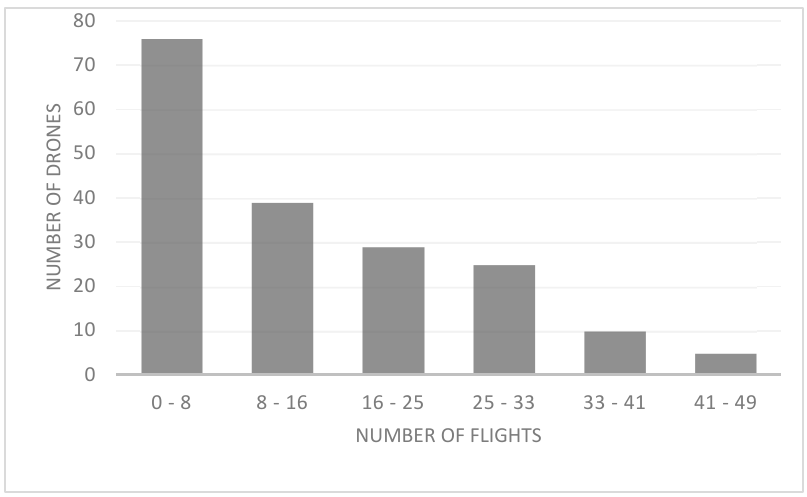
Figure 4. Number of drones and number of flights, by range, during the mating season in NW Argentina.